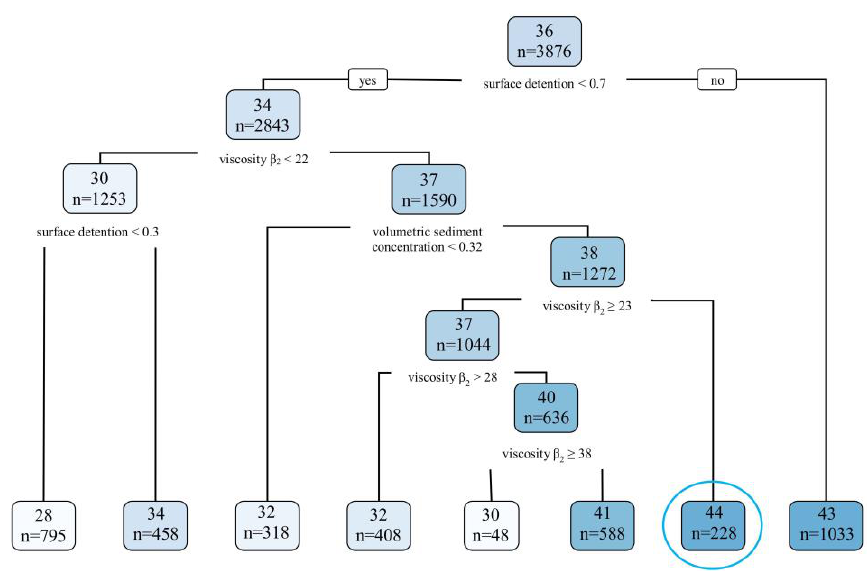
Figure 7. Regression tree based on averaged F statistic values; cp = 0.02.